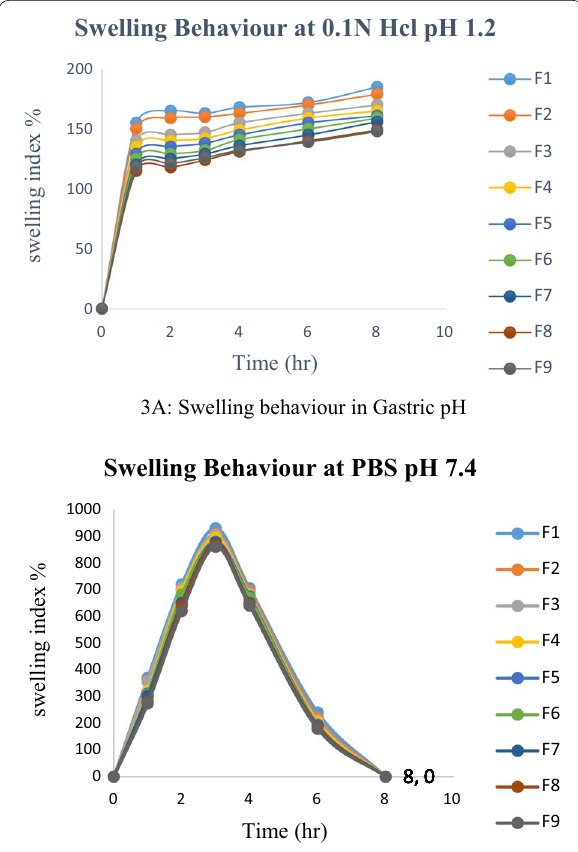
Fig. 4 The in vitro wash off test of prepared microsphere was Fig. 3 The swelling behaviour of the prepared gliclazide-loaded mucoadhesive microsphere was carried in gastric pH A (0.1 N HCl, pH 1.2). The behaviour of swelling of all the nine batches of prepared mucoadhesive microsphere was carried out for around 8 h. Values represent mean SD of an experiment done in ± triplicate. The swelling behaviour of the prepared gliclazide-loaded